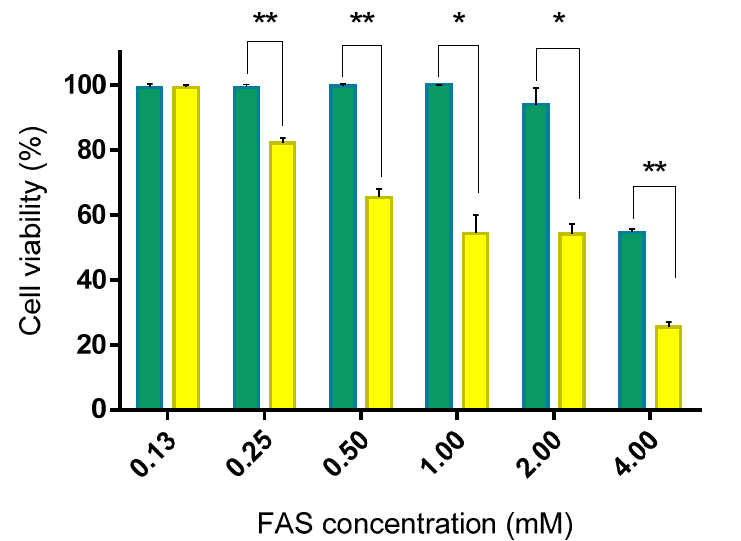
Figure 2. 4T1-Qt ( a ) and 4T1 ( b ) cells stained with Alexa Fluor 647 anti-DYKDDDDK Tag antibody (red fluorescence). Nuclei were counterstained with DAPI (blue fluorescence). Laser scanning con- focal microscopy, scale bar 20 µm.